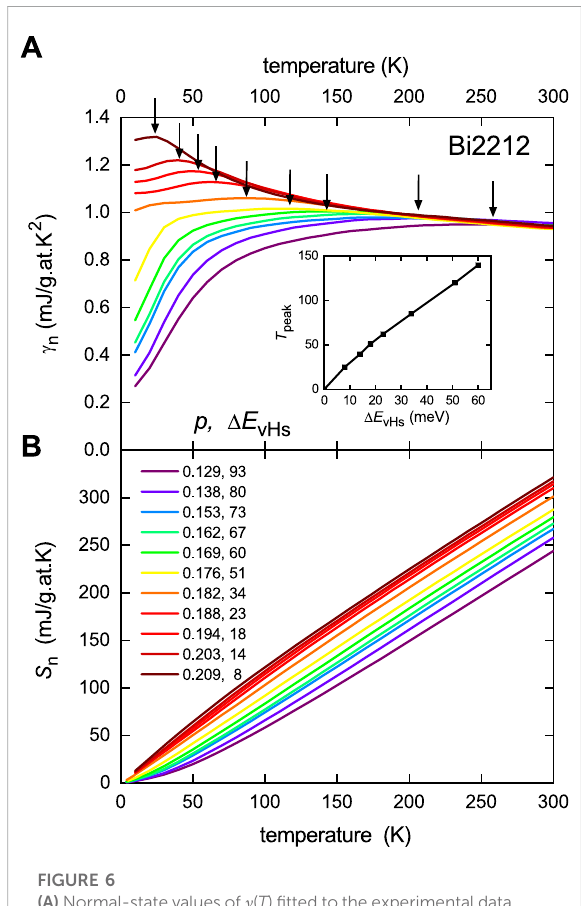
FIGURE 6 (A) Normal-state values of γ ( T ) fi tted to the experimental data for Bi2212 [25] using the ARPES-derived dispersion of Kaminski et al. [26] and evaluated below T c by entropy balance. The peaks associated with the proximate van Hove singularity are indicated by arrows. (B) The normal-state electronic entropy obtained by integrating γ n ( T ) in (B) . The different doping levels, p , are given in the legend along with the energy difference, Δ E vHs , of the vHs below E F in meV. The inset shows the dependence of the vHs peak temperature on Δ E vHs